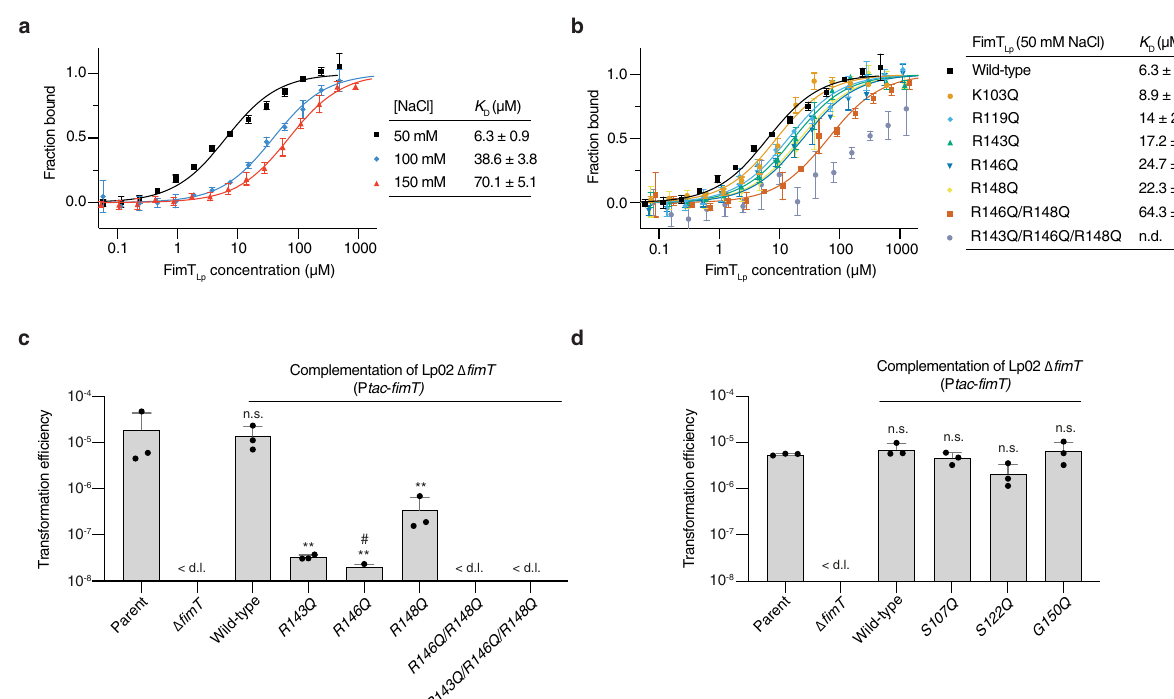
Fig. 4 Characterisation of FimT Lp binding to DNA in vitro and in vivo. MST/TRIC binding assay of 12 bp FAM-labelled dsDNA with a , wild-type FimT Lp performed at different NaCl concentrations (ionic strength) and b , wild-type FimT Lp compared to FimT mutants predicted to disrupt DNA binding based on Fig. 3. n.d., not determined. The MST/TRIC data were fi tted according to two binding sites with equal af fi nity. Error bars represent the mean ± SD (n = 3). c , d , Natural transformation ef fi ciencies of parental Lp02, Lp02 Δ fi mT , and the Lp02 Δ fi mT strain complemented by ectopic expression of wild-type and FimT Lp mutants that disrupt DNA binding ( c ) or do not contribute to DNA binding according to Fig. 3 ( d ). The mean transformation ef fi ciencies of three independent biological replicates are plotted with error bars representing the SD. < d.l., below detection limit (d.l.) (average d.l. = 2.0 × 10 − 8 ± 8.2 × 10 − 9 (c) and 2.5 × 10 − 8 ± 9.5 ×10 − 9 (d)); #, below d.l. in at least one replicate (average d.l. used to calculate the mean transformation ef fi ciency). The assay in panel c was performed in parallel to those displayed in Fig. 1a, and statistical differences were determined on log-transformed data using an unpaired two- sided t-test with Welch ’ s correction. The Lp02 Δ fi mT strain complemented with mutants was compared to the Lp02 Δ fi mT strain complemented with wild- type FimT, which was in turn compared to the parental strain. **, p < 0.01 ( p R143Q = 0.003; p R146Q = 0.002; p R148Q = 0.004); n.s., not statistically signi fi cant, p > 0.05 ( p Wild-type(c) = 0.89; p Wild-type(d) = 0.33; p S107Q = 0.38; p S122Q = 0.08; p G150Q = 0.89). Source data are provided as a Source Data fi